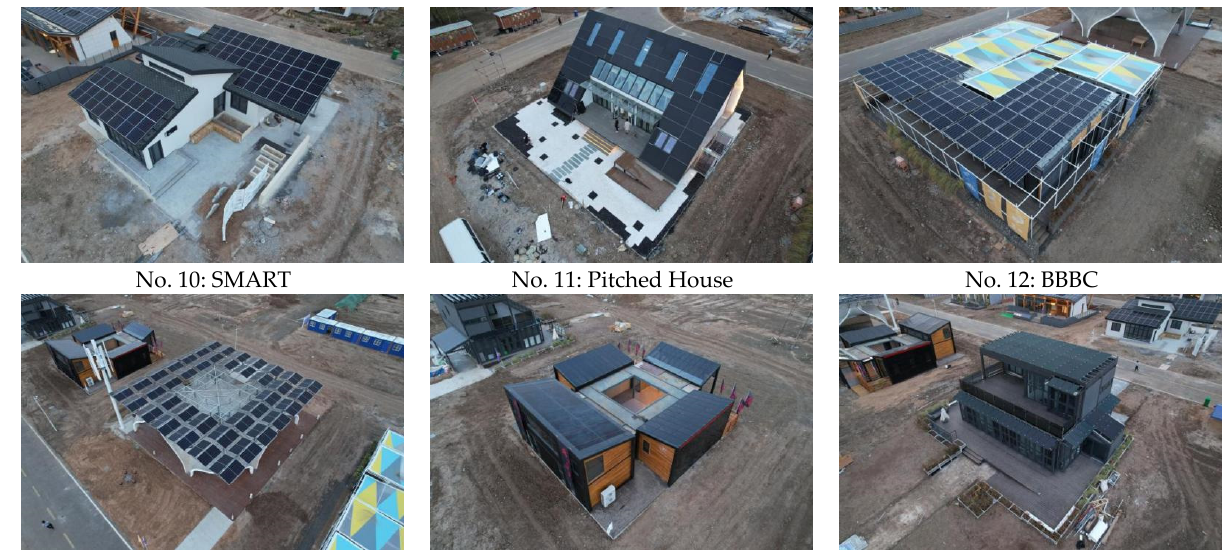
Figure 2. Buildings site photos.